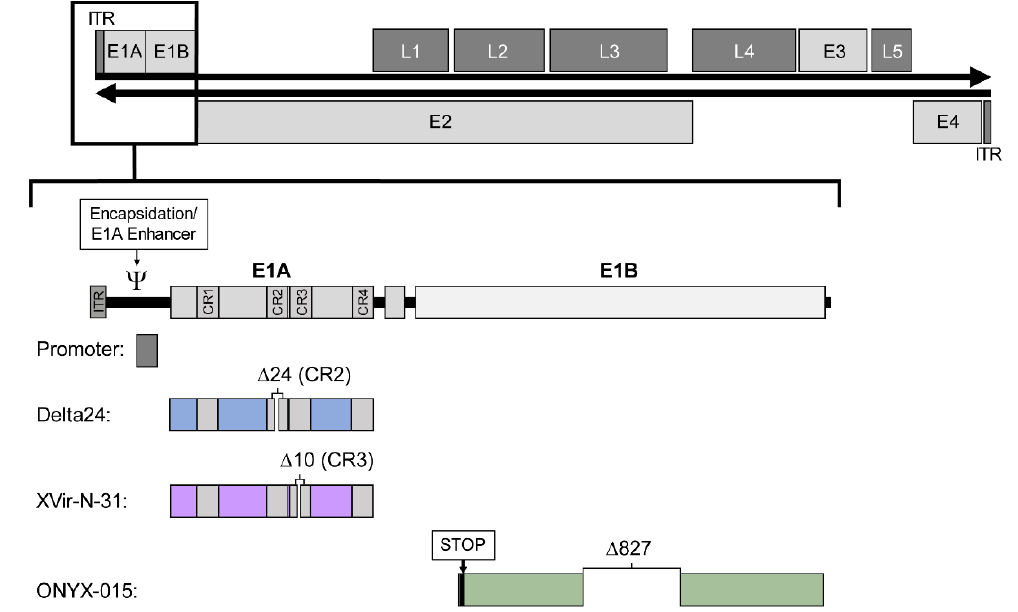
Figure 1. Structure of the wild-type adenovirus serotype 5 genome and the four concepts for generating conditionally replicating adenoviruses applied in vectors of current clinical trials. The affected E1 region is shown enlarged to illustrate the changes. The double-stranded DNA of about 36 kb in length (black horizontal arrows), flanked by two inverted terminal repeats (ITR) comprises four early transcription units (E1–E4, light grey boxes) and five late transcription units (L1–L5, dark grey boxes). The E1 region (enlarged below) consists of the encapsidation signal/E1A enhancer, the E1A promoter, E1A with four conserved regions (CR1–CR4) and E1B. The four concepts are listed below: Changes in the promoter (grey), Delta24 (blue) with a deletion in CR2, XVir-N-31 (purple) with a deletion in CR3, and ONYX-015 (green) with a stop codon and a deletion in E1B55K.